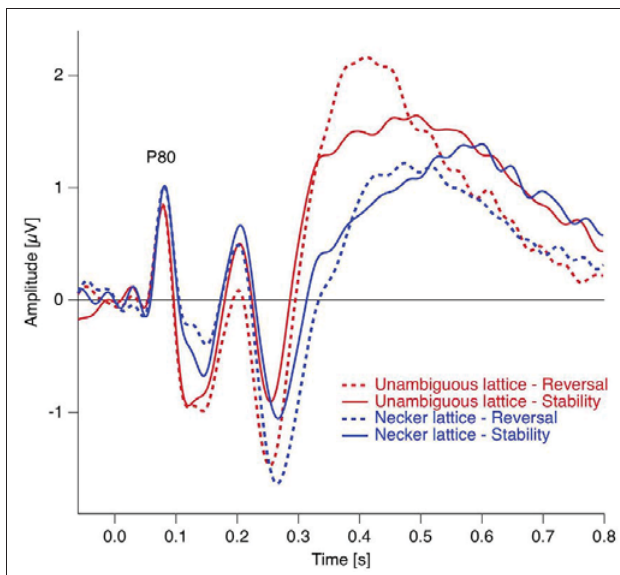
FIGURE 6 | Grand mean ERP traces from the occipital electrode position. As can be seen, the early visual ERP components are very similar across conditions (reversal, dotted traces and stability, continuous traces) and experiments (Necker lattices, blue, and unambiguous variants, red). Data from Kornmeier and Bach